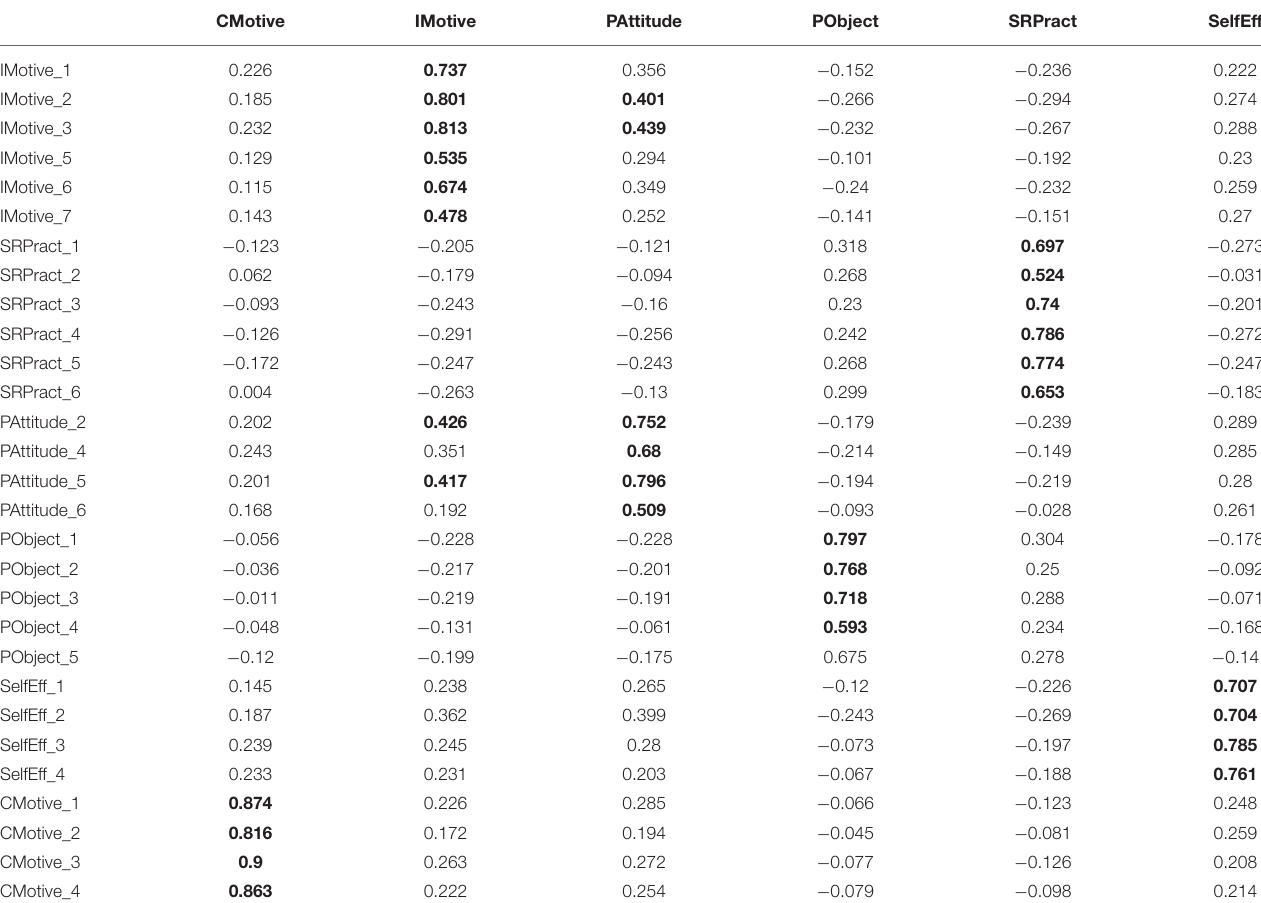
TABLE 4 | Factor loading matrix for reflective factors. CMotive IMotive PAttitude